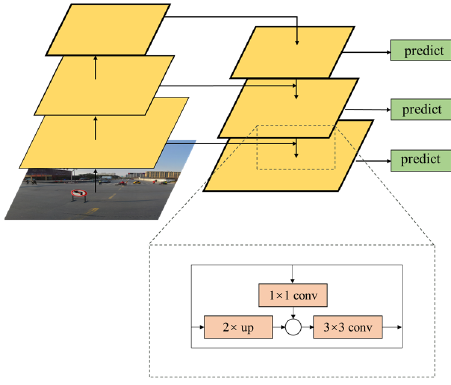
Figure 4. FPN structure.